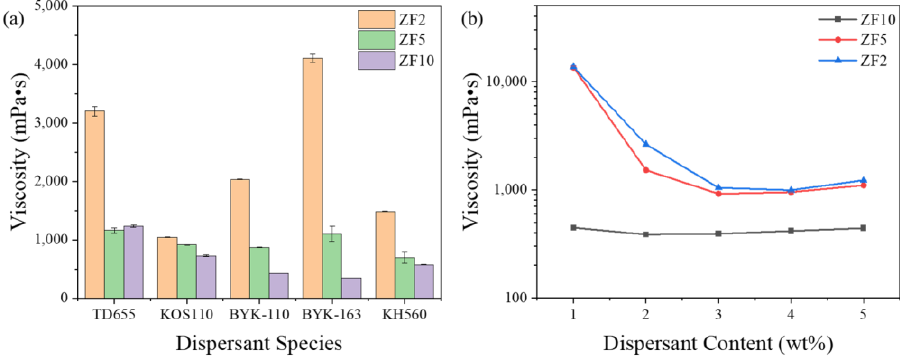
Figure 4. Effects of ( a ) dispersant species and ( b ) dispersant content on slurry viscosity.